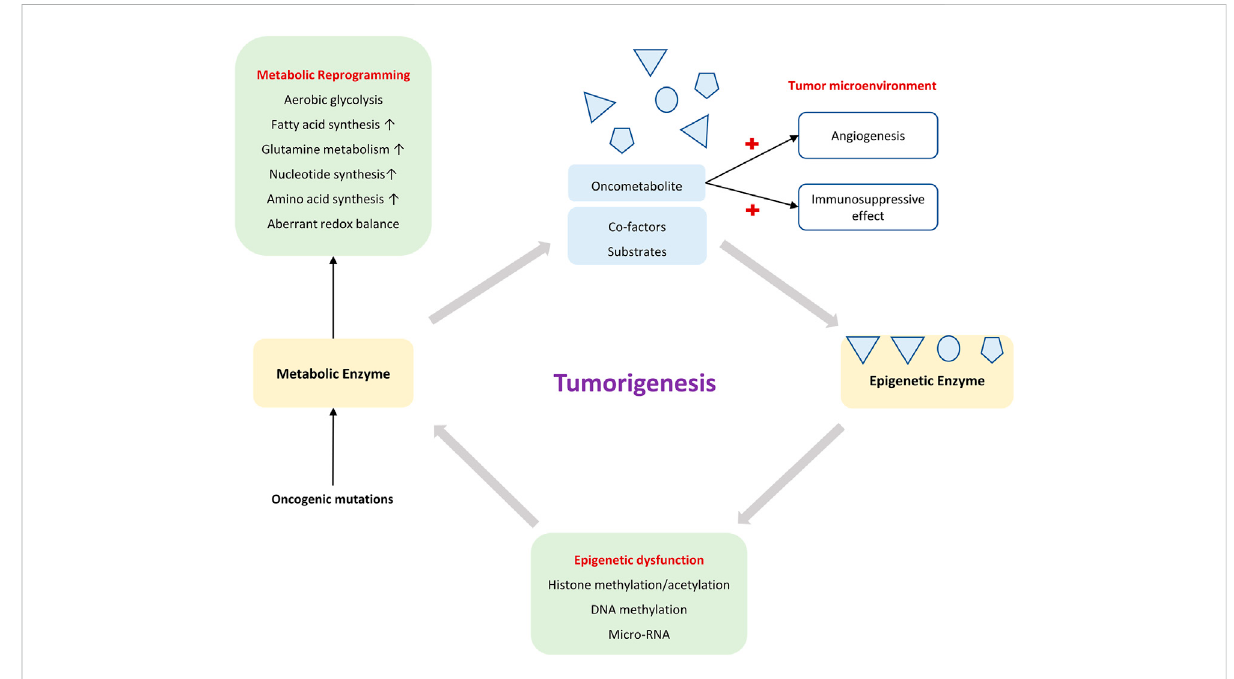
FIGURE 3 The crosstalk between metabolism and epigenetics in